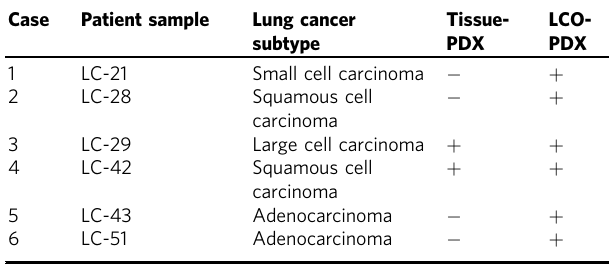
Table 4 Comparison of graft success between direct tissue graft and 3D-organoid graft methods Case Patient